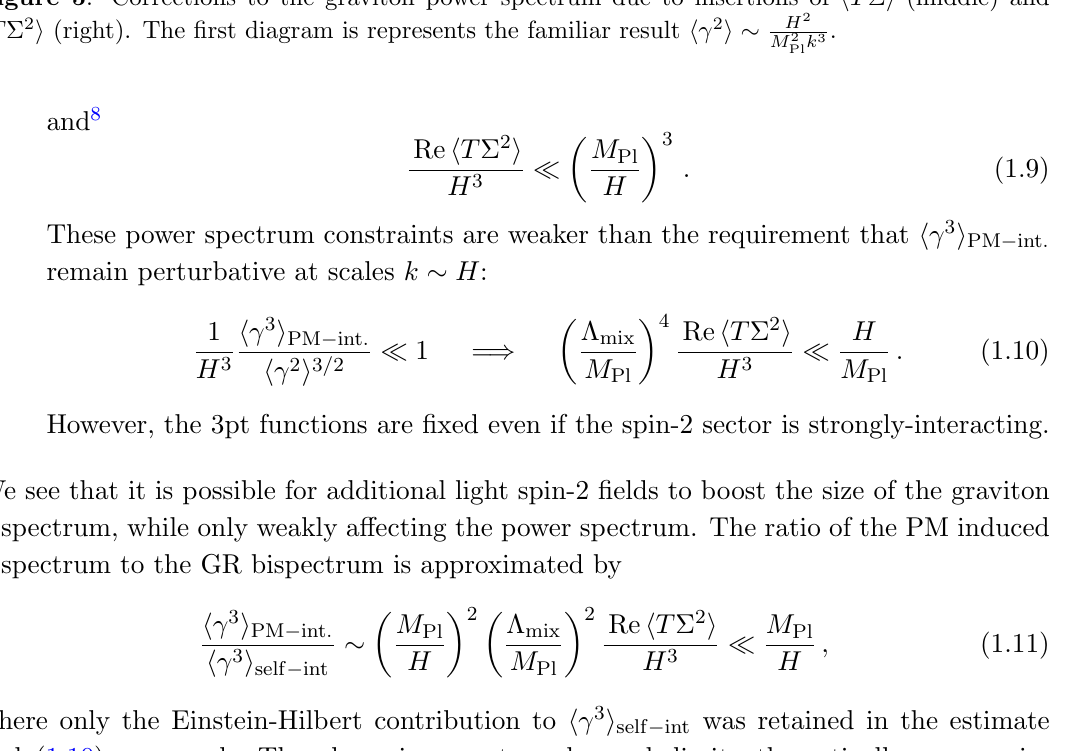
T Σ (middle) and h i H 2 . γ 2 M 2 Pl k 3 h i ∼